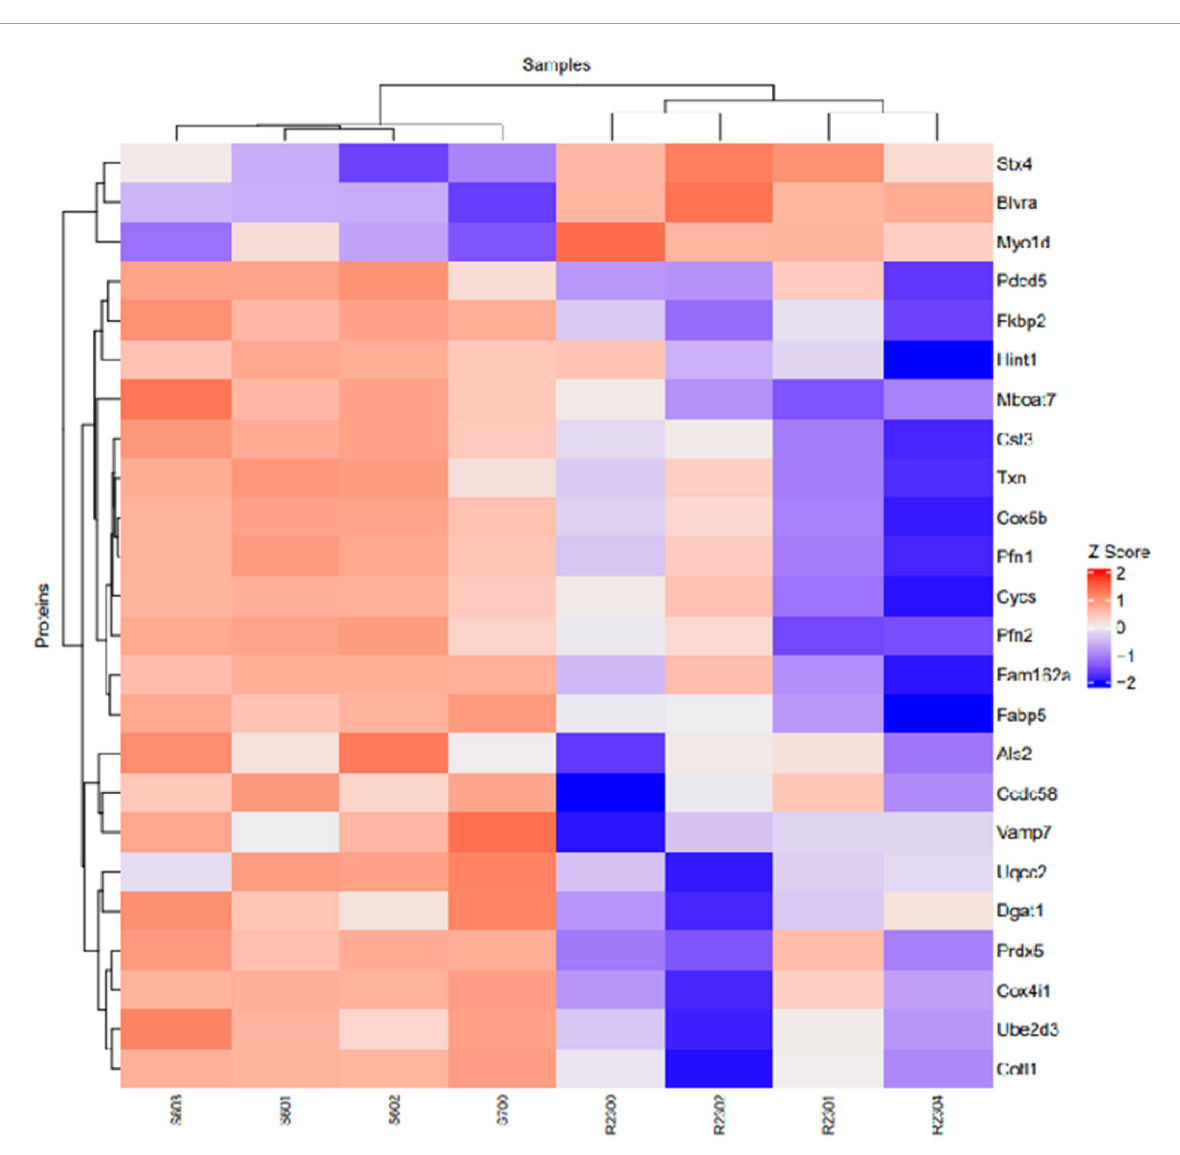
FIGURE11 Heatmap of proteins identified in network 1 with their corresponding samples. S, Sham; R,